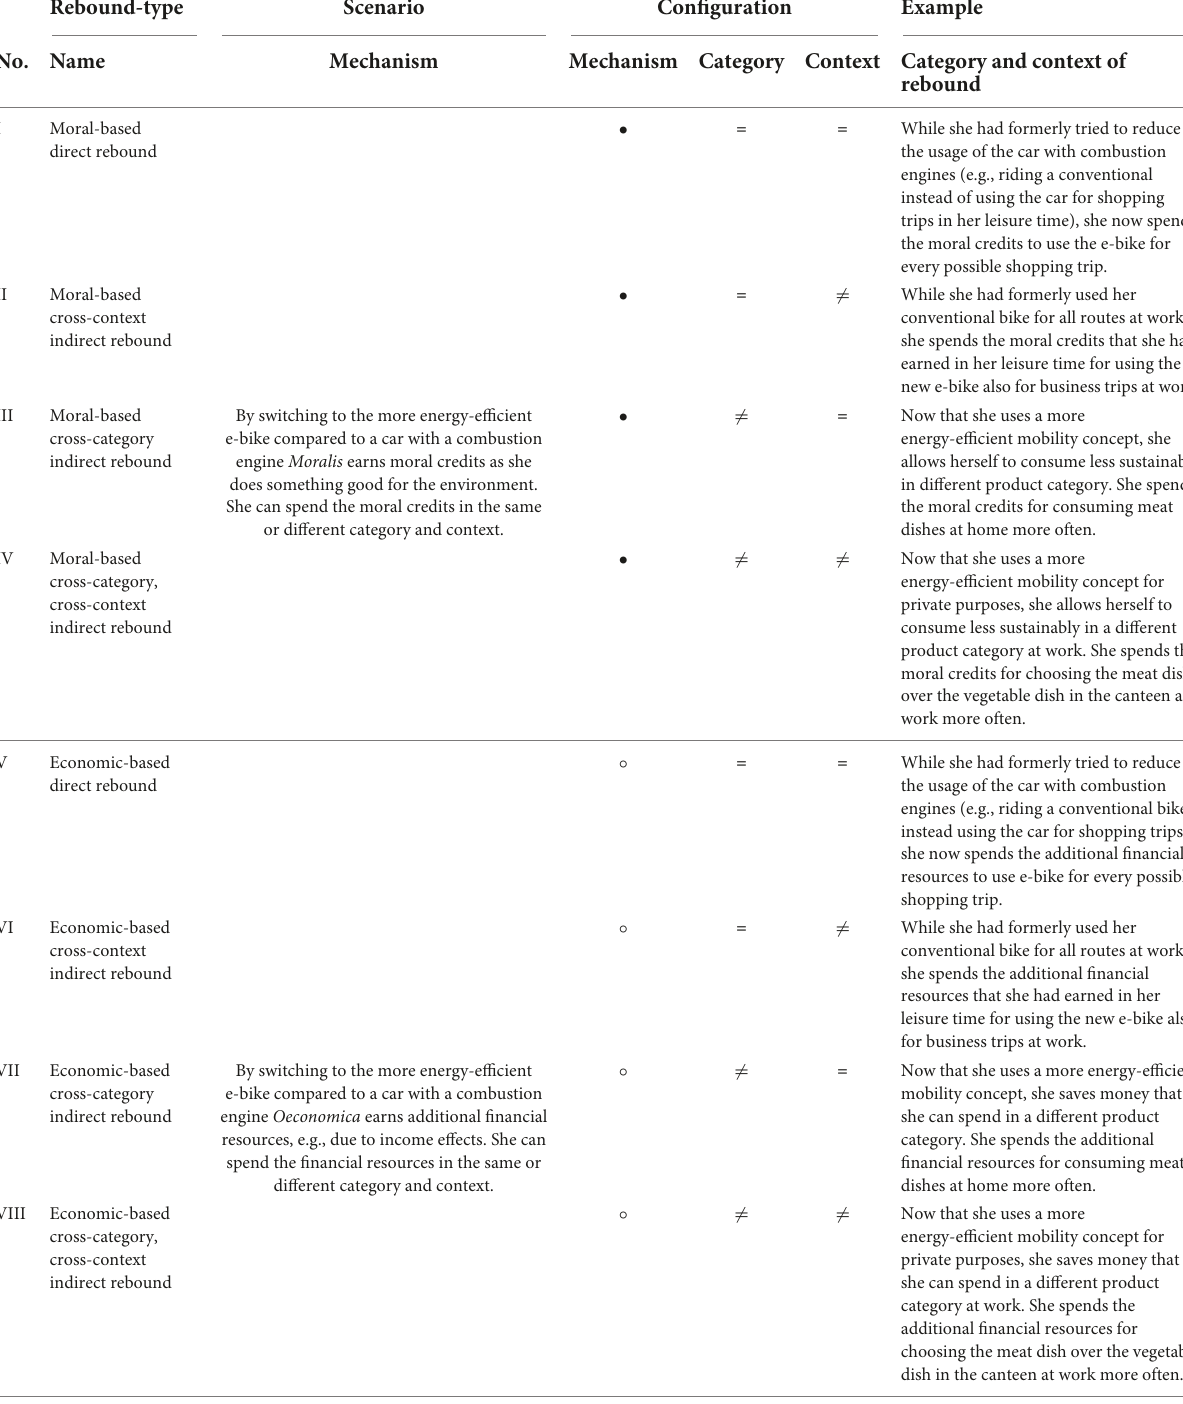
TABLE 2 Examples of rebounds according to the rebound